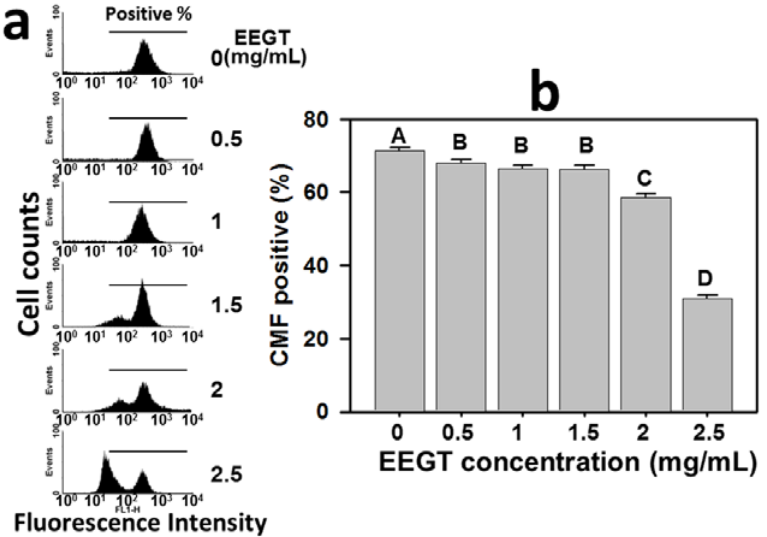
Figure 5. Ethanolic extracts of G. tenuistipitata (EEGT) induced glutathione (GSH) depletion of Ca9-22 oral cancer cells. ( a ) Flow cytometry-based GSH profiles for EEGT-treated cells. Cells treated with different concentrations (0 to 2.5 mg/mL) of EEGT for 24 h. Positive % is indicated in each panel; ( b ) Quantificative analysis of CMF-positive %. Data are presented as mean ± S.D. (n = 3). Differences between treatments of different concentrations containing the same capital letter at the top of each column are not